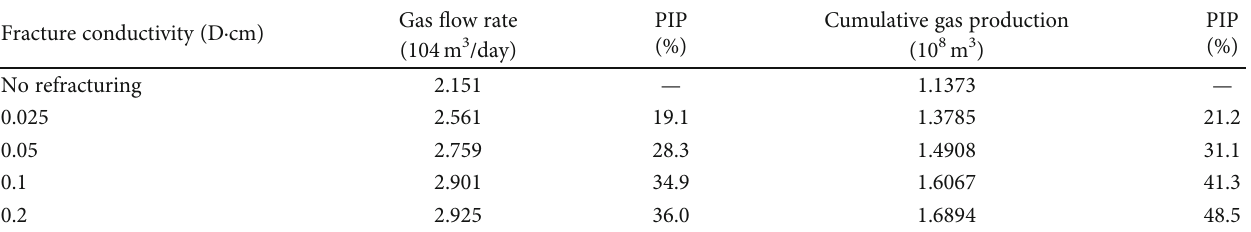
No refracturing Refracturing_fracture conductivity 0.025 D.cm Refracturing_fracture conductivity 0.05 D.cm Refracturing_fracture conductivity 0.1 D.cm Refracturing_fracture conductivity 0.2 D.cm